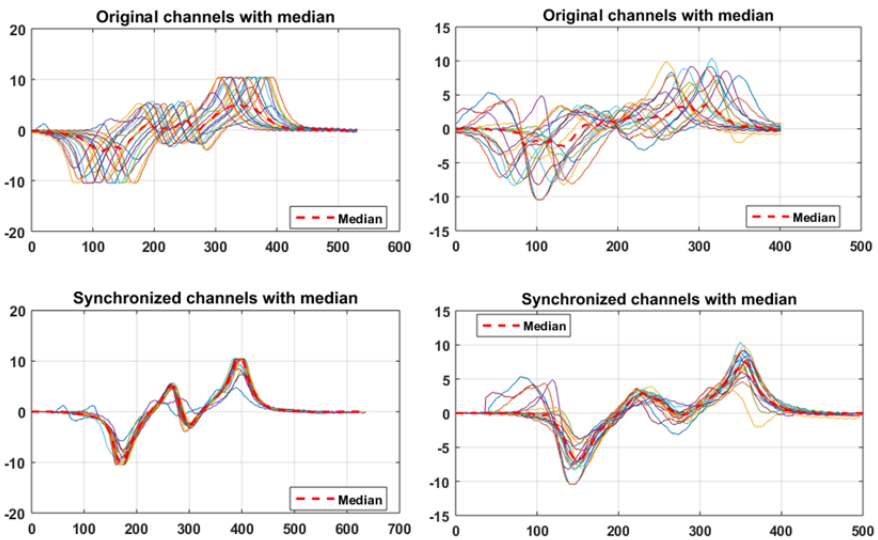
Figure 14. Results of synchronization with a genetic algorithm for the correctly made splice (left panels) and the faulty splice (right panels).